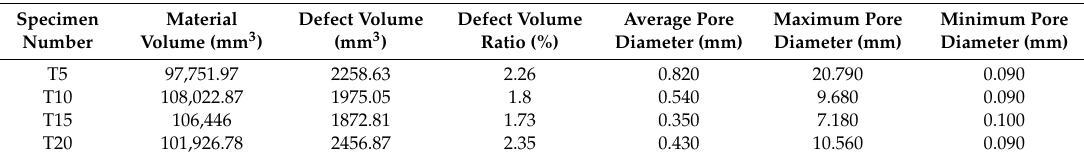
Table 5. Volumetric analysis.